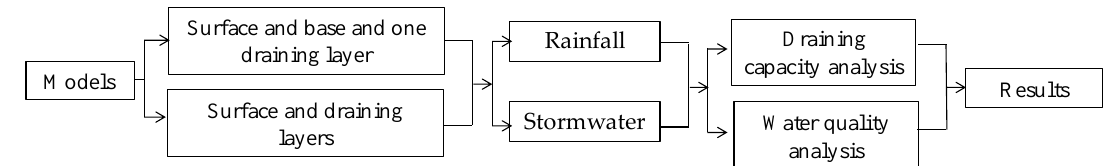
Figure 1. Scheme of the methodology used in this study.